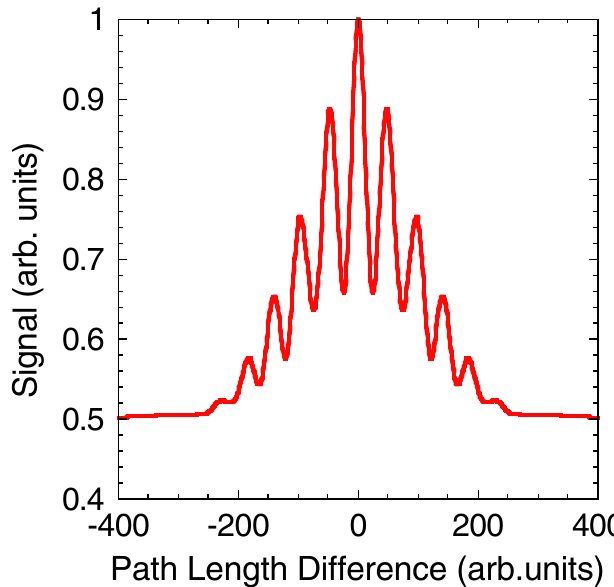
FIG. 8. (Color) Autocorrelation trace calculated from the bunch profile of Fig. 6 with six bunches and using Eq. (12). The horizontal scale is kept arbitrary since it depends on the actual total bunch length after the dogleg.